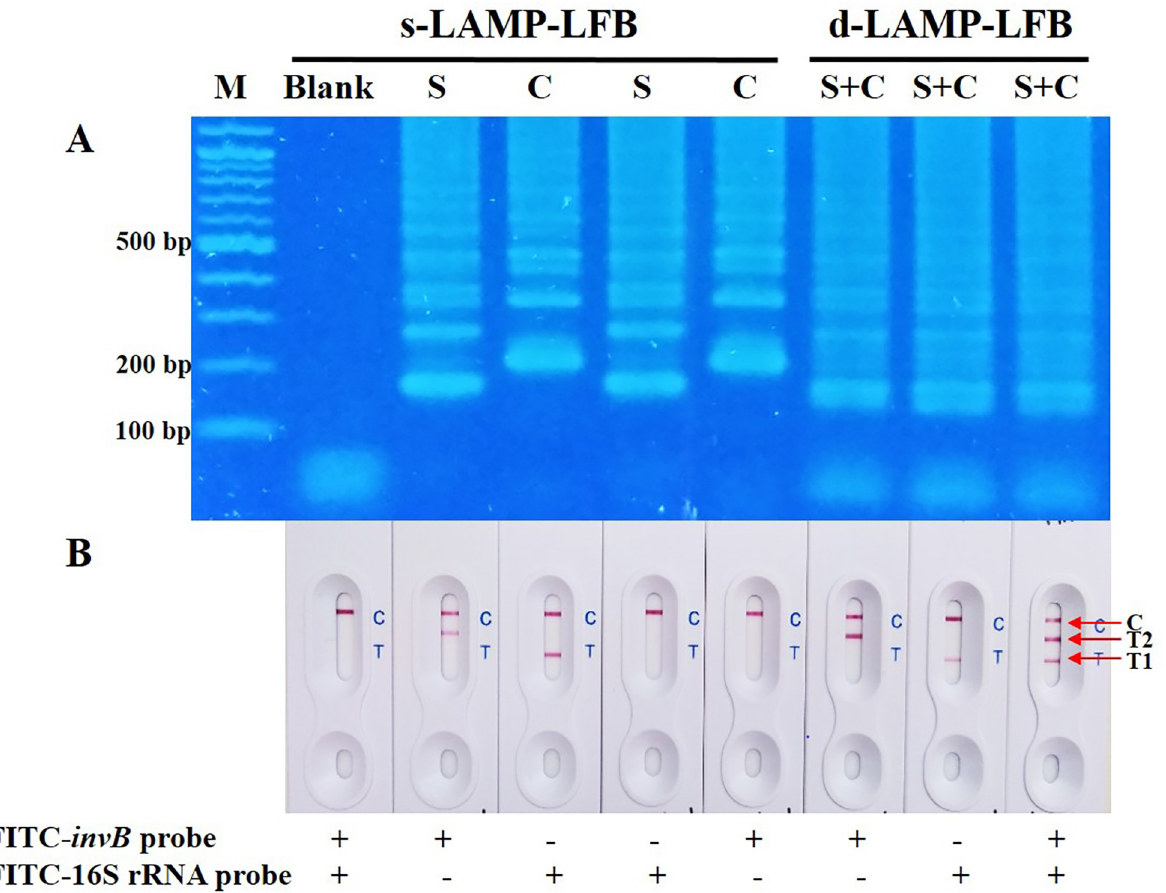
Fig 2. Detection and differentiation of LAMP products visualized by 2% agarose gel electrophoresis in comparison to LFB. (A) Electrophoretic analysis represented the distinctive ladder-like patterns of LAMP amplification products for S: S . Typhimurium; C: C . jejuni ; SC: S . Typhimurium + C . jejuni ; M: 2-log DNA ladder 100 bp; Blank: the reaction with 2 μ l sterile distilled water. (B) LFB analysis showed the simultaneous detection of multiple targets with distinguishing by visualizing band that appear on the C: control line; T1: test line 1 of C . jejuni ; T2: test line 2 of S .